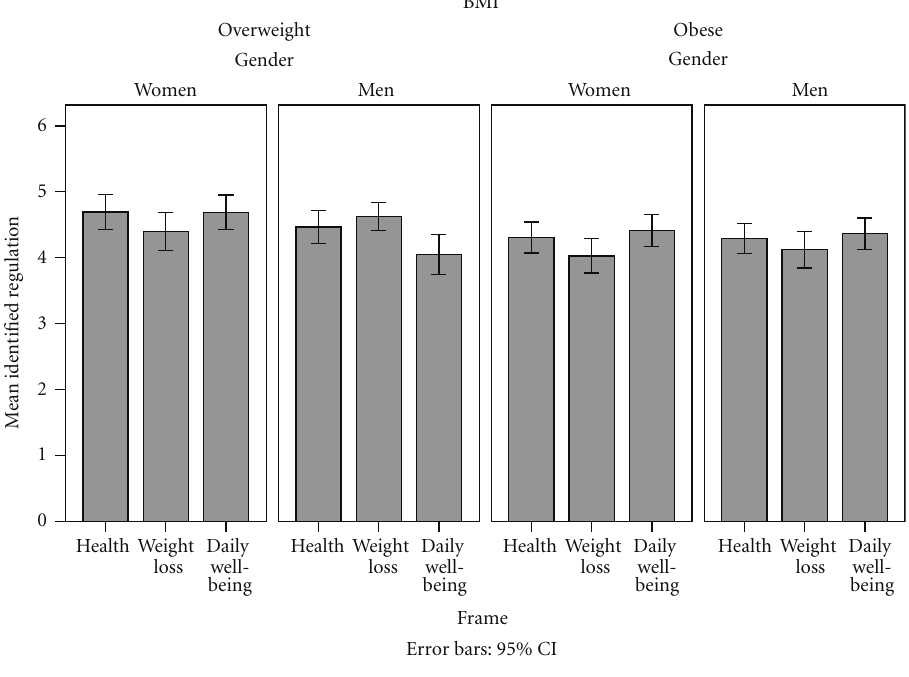
Figure 4: Identified